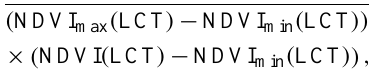
of 0.004 (Chen et al., 2013b), and the heat roughness length of bare soil was calculated according to Yang et al.